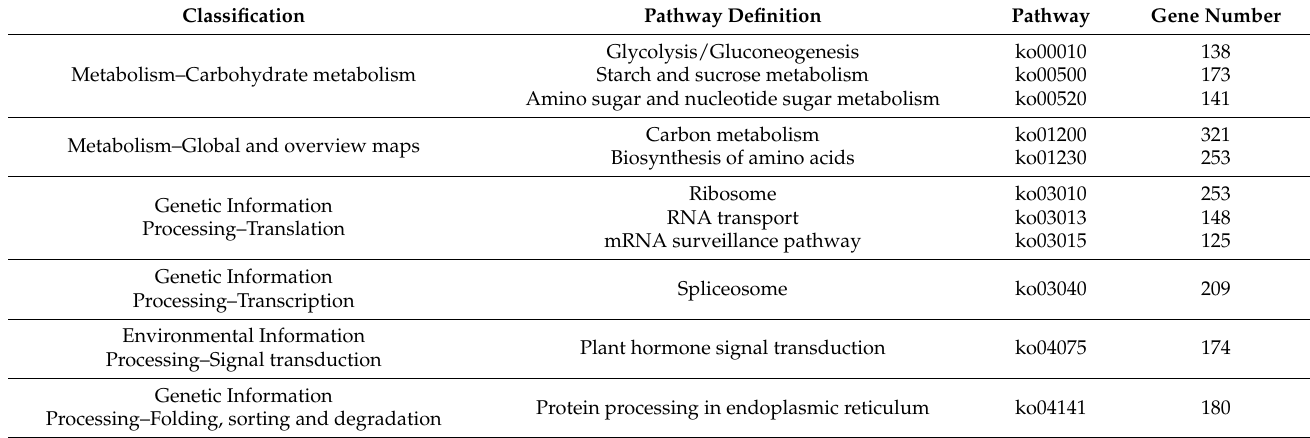
Table 3. The top 11 pathways of function annotation in KEGG